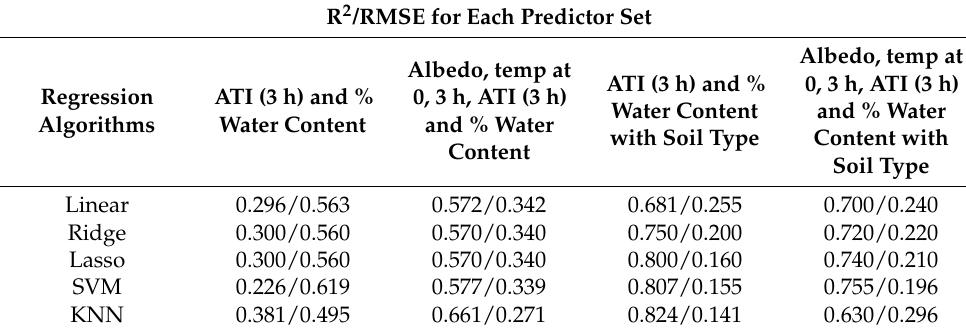
Table 4. Table of Prediction accuracy (R 2 ) and Root Mean Squared Error (RMSE) for each of the regression models implemented on each predictor